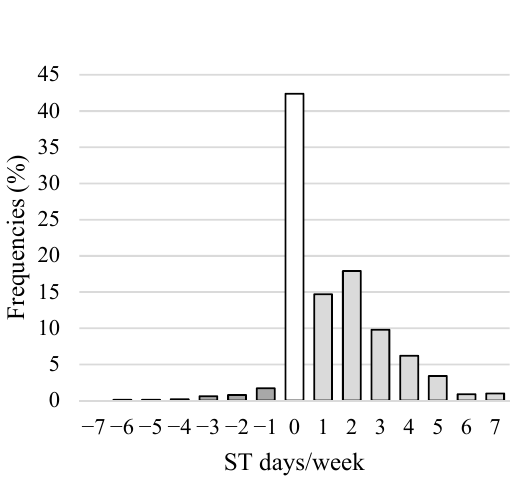
Figure 2. Distribution of the changes (days/week during distance education–before distance education) in the level of aerobic exercise ( A ) and muscle strengthening ( B ), and time spent in front of the screen in the evenings ( C ). Notes. AE: aerobic exercise, MS: muscle strengthening, ST: screen time; AE days/week = AE days/week during distance education–AE days/week before distance education, MS days/week = MS days/week during distance education–MS days/week before distance education, ST days/week = ST days/week during distance education–ST days/week before distance education, white bars: no changes, i.e., the number of the days/week before and during distance education is equal, light grey bars: increase, i.e., days/week during distance education > days/week before distance education, dark grey bars: decrease, i.e., days/week during distance education < days/week before distance education. Table 2. Shift table for the level of aerobic exercise before and during distance education. AE Days/Week during Distance Education